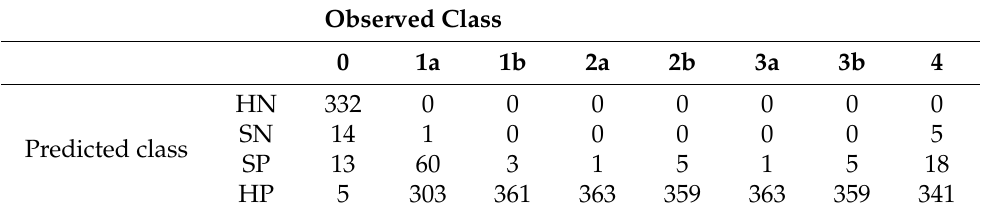
Table 13. Confusion matrix for the validation set and the RF model. Multi-class classification.